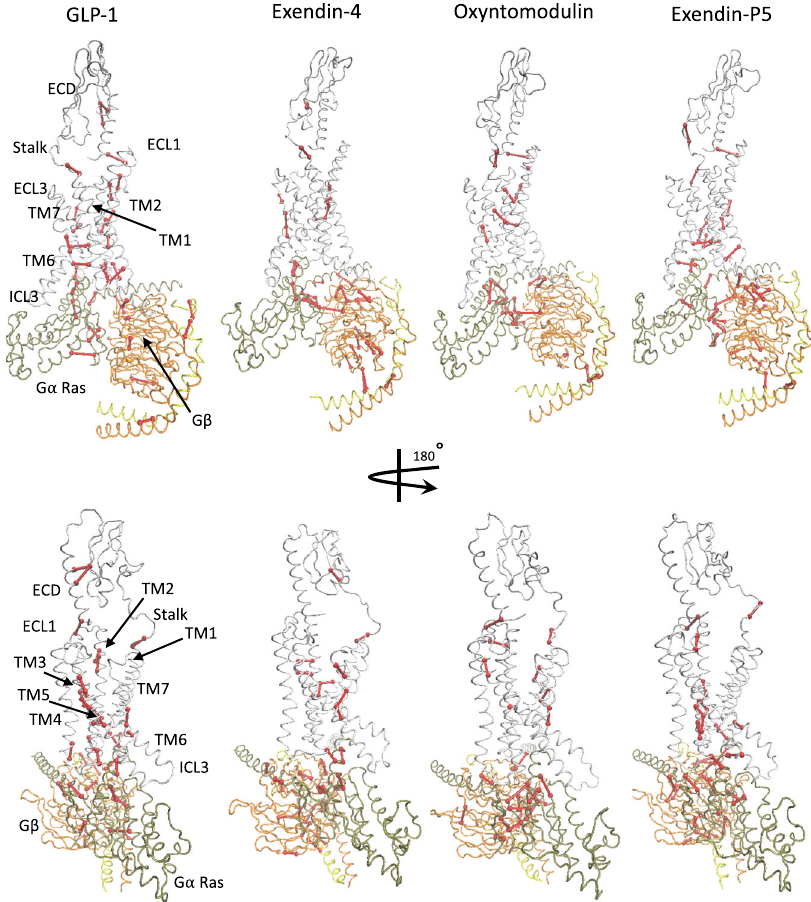
Fig. 9 Position of critical nodes within GLP-1R, in complex with GLP-1, exendin-4, oxyntomodulin, or exendin-P5. GLP-1R is in white ribbon, G α in tan ribbon, G β in orange ribbon, and G γ in yellow ribbon. Nodes and edges are in red. Peptides are not displayed as these were not considered during network